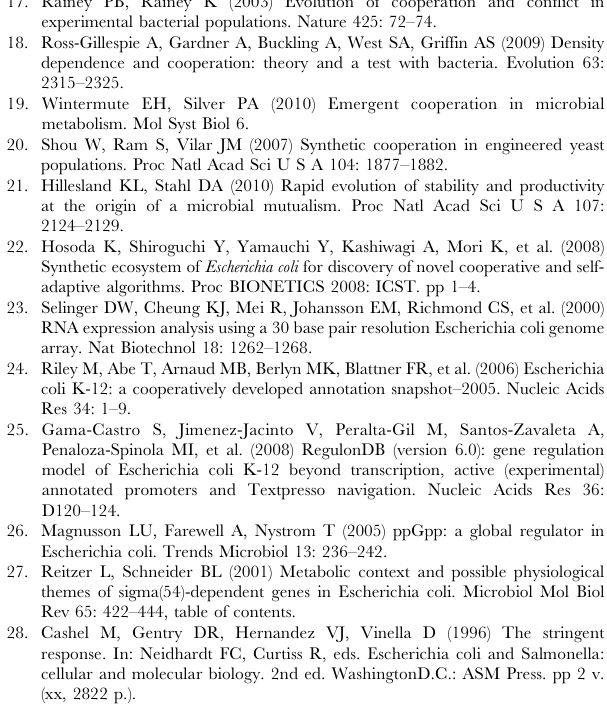
Table S1 Explanations and values of the parameters used in the mathematical